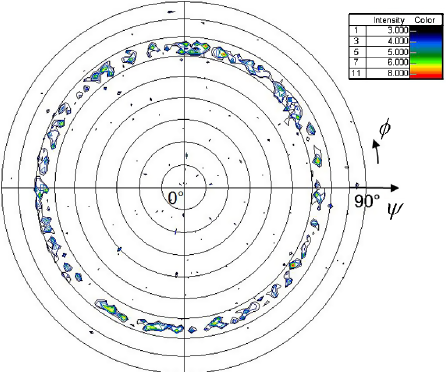
FIG. 23. Pole figure of (3 1 0) (cid:8) - Ti L51. (cid:9) is the angle of rotation around the direction normal to the sample. c is the tilt angle from the normal direction.